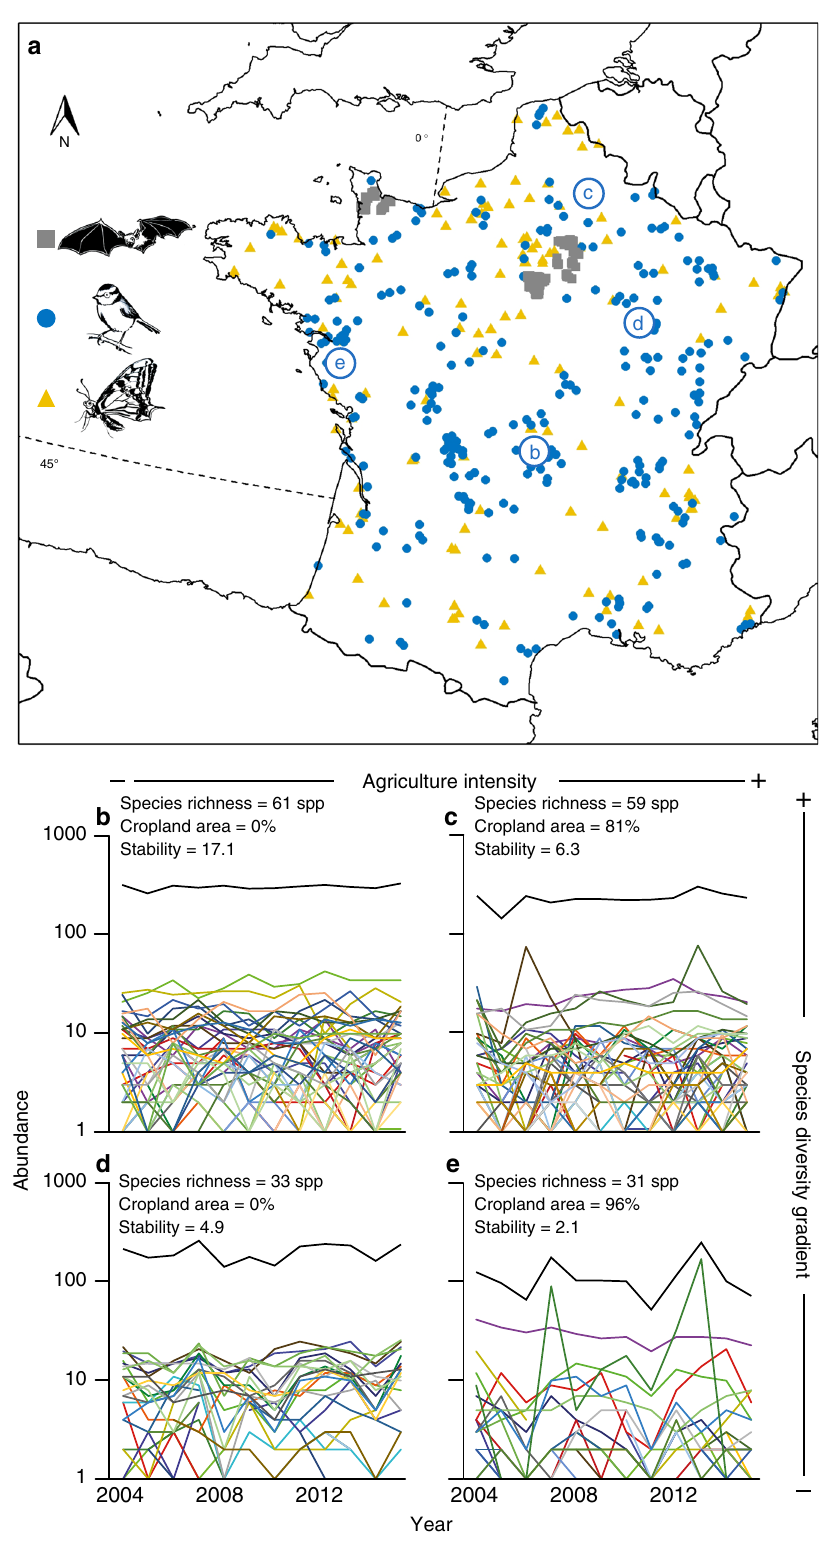
Fig. 1 Datasets. a Spatial distribution of the monitored bat, bird and butter fl y communities across France. Circled letters correspond to the bird communities with contrasted levels of species richness and cropland area within buffer plotted in ( b – e ). Each colored line represents a given species abundance time series and black lines represent total community abundance time series. Species richness, cropland area within buffer, and stability (computed as the inverse of the coef fi cient of variation) of the total community abundance time series are given for each bird